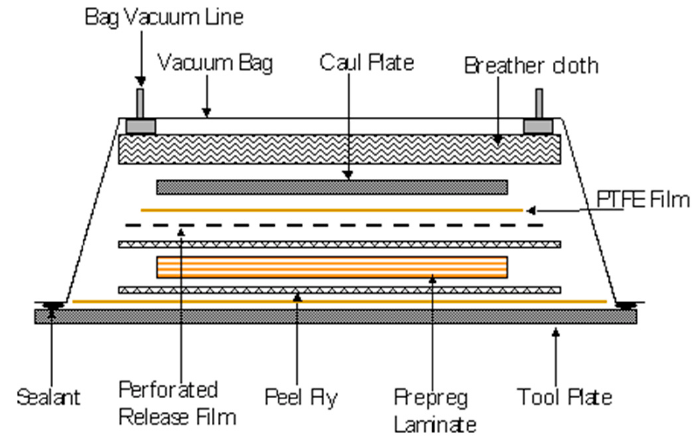
Figure 13. Schematic illustration of the key components of the materials contained within the vacuum bag in the autoclave (the pre-stressing rig is not shown).